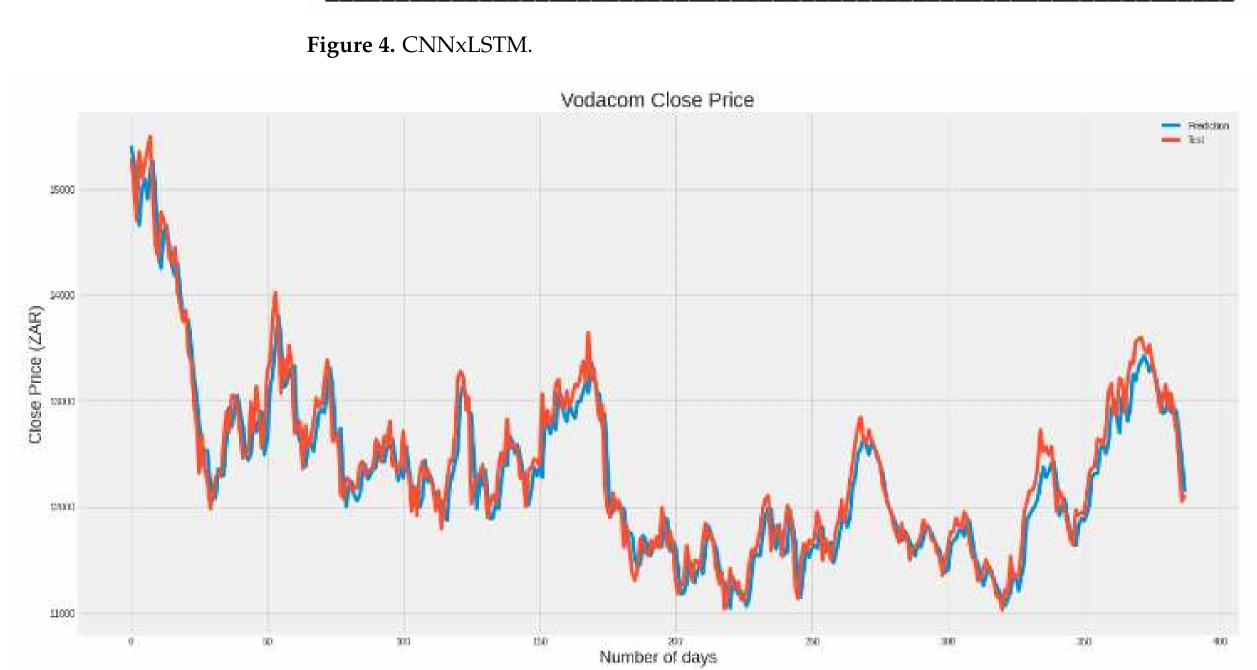
Figure 5. CNNxLSTM Experiment